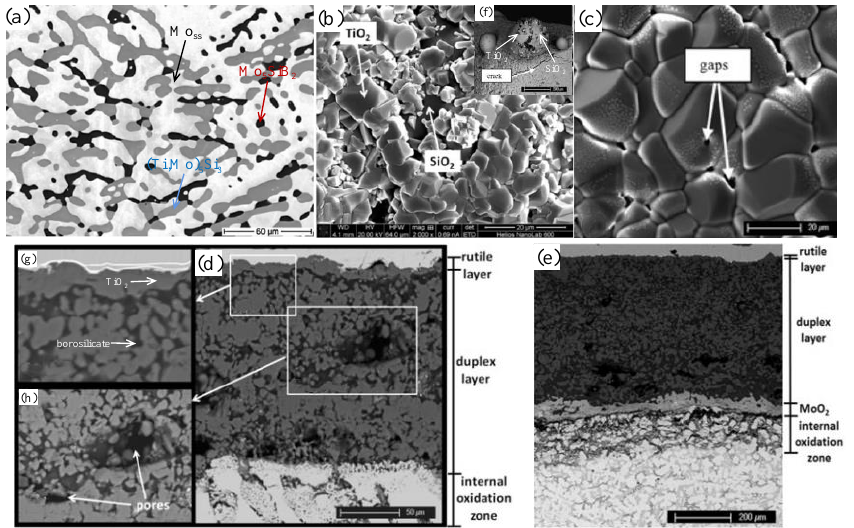
Figure 12. SEM (BSE) images of Mo-9Si-8B-29Ti composite: ( a ) microstructure, ( b , c , f ) surface and ( d , e , g , h ) cross section after oxidation 100 h at ( b , d , f – h ) 1100 °C, ( c ) 1200 °C and ( e ) 1300 °C. ( a – h ) reproduced with permission [58,59], respectively. Copyright 2013 Springer Nature.